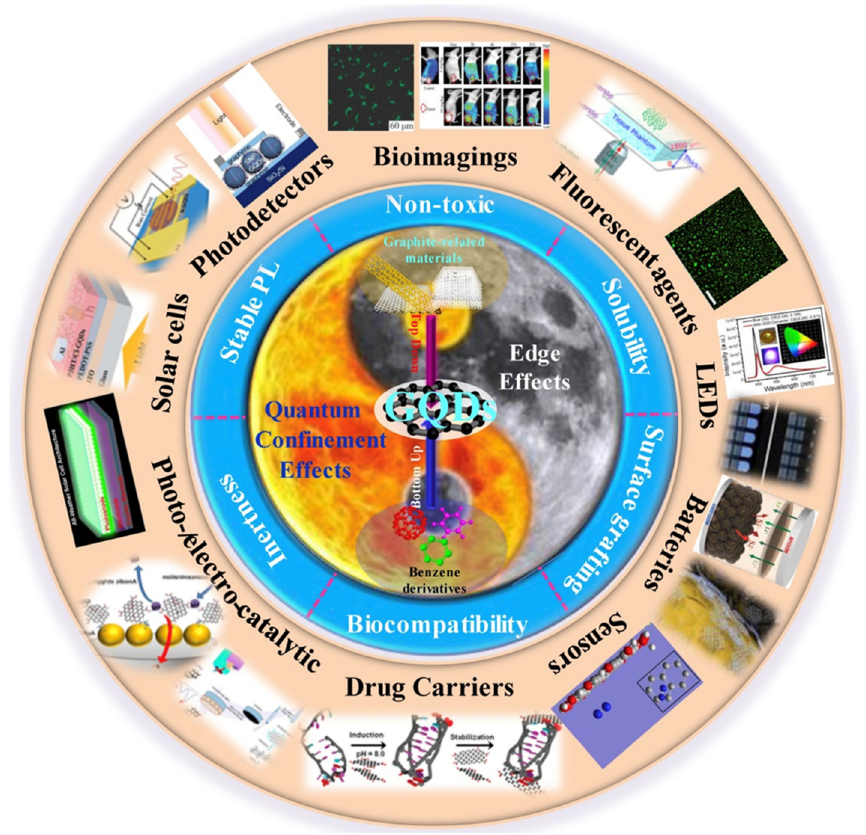
Figure 10. GQDs related inherent effects, preparation methods, properties, and applications. Repro- duced from Ref. [53] with permission from ELSEVIER. Copyright 2018